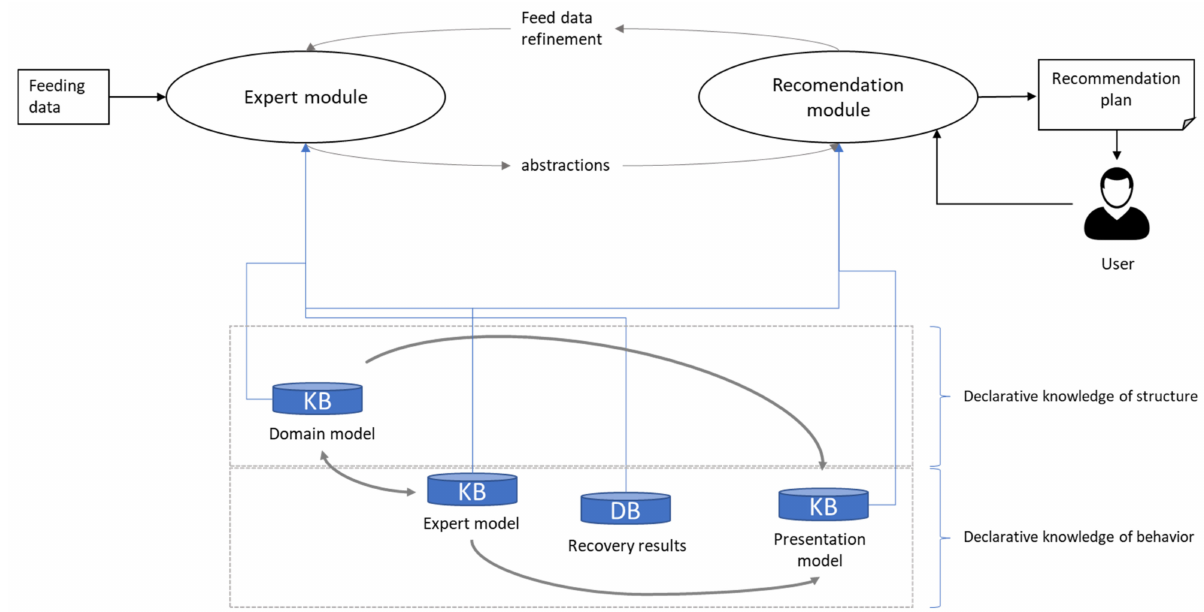
Figure 2. The architecture of the proposed recommendation